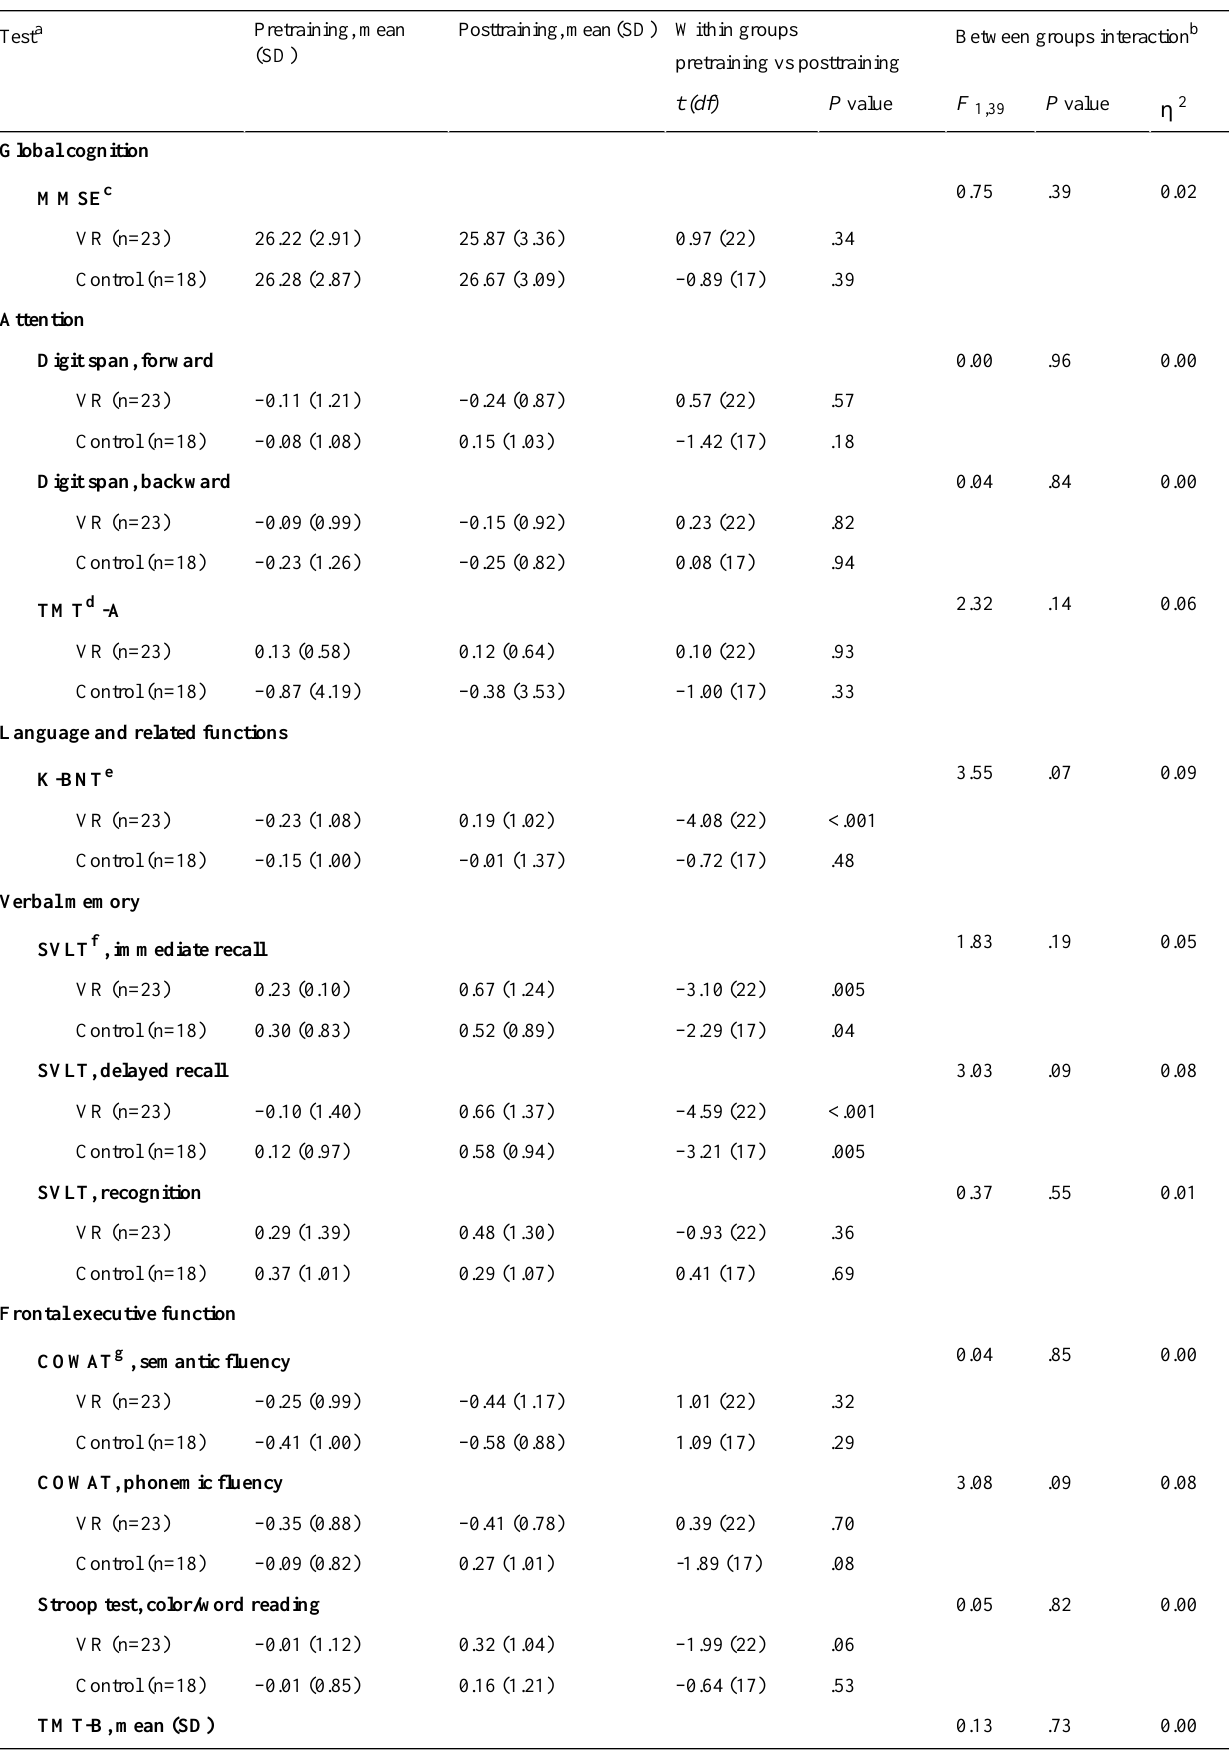
Table 3. Group comparisons of comprehensive neuropsychological tests pre and post virtual reality (VR) cognitive